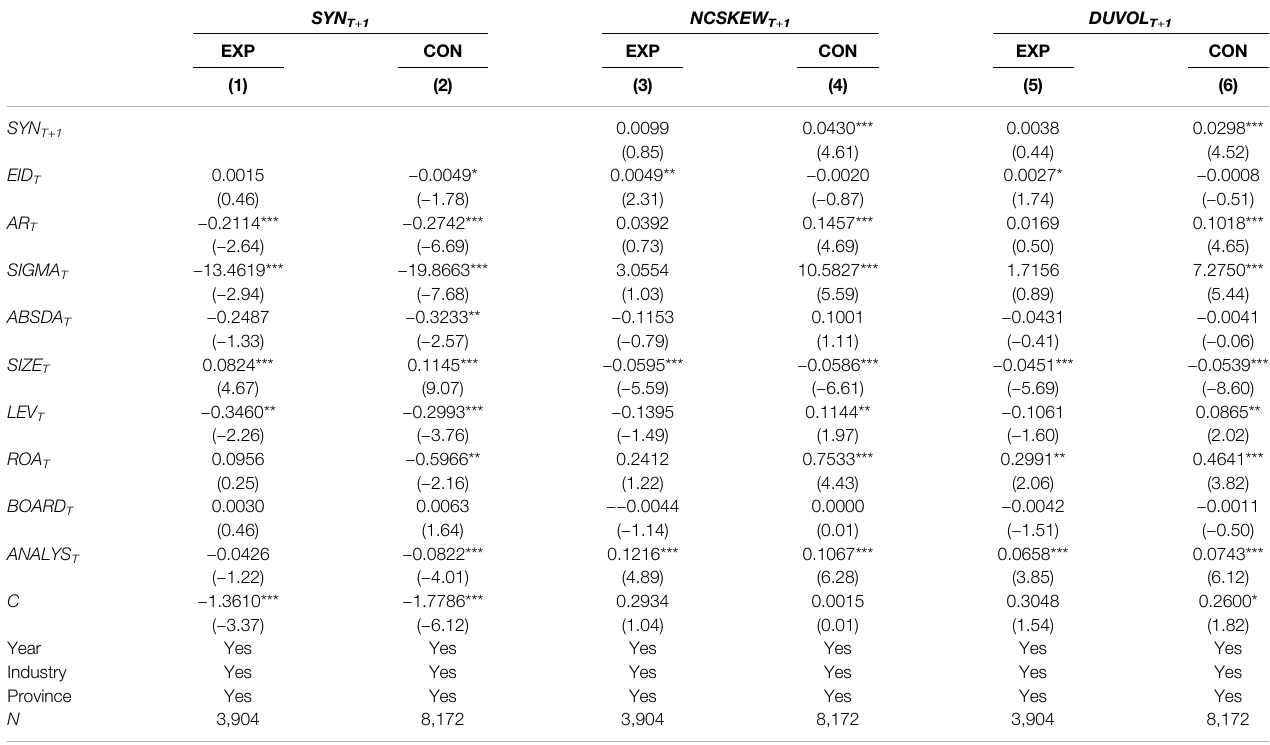
TABLE 5 | Test of information ef fi ciency